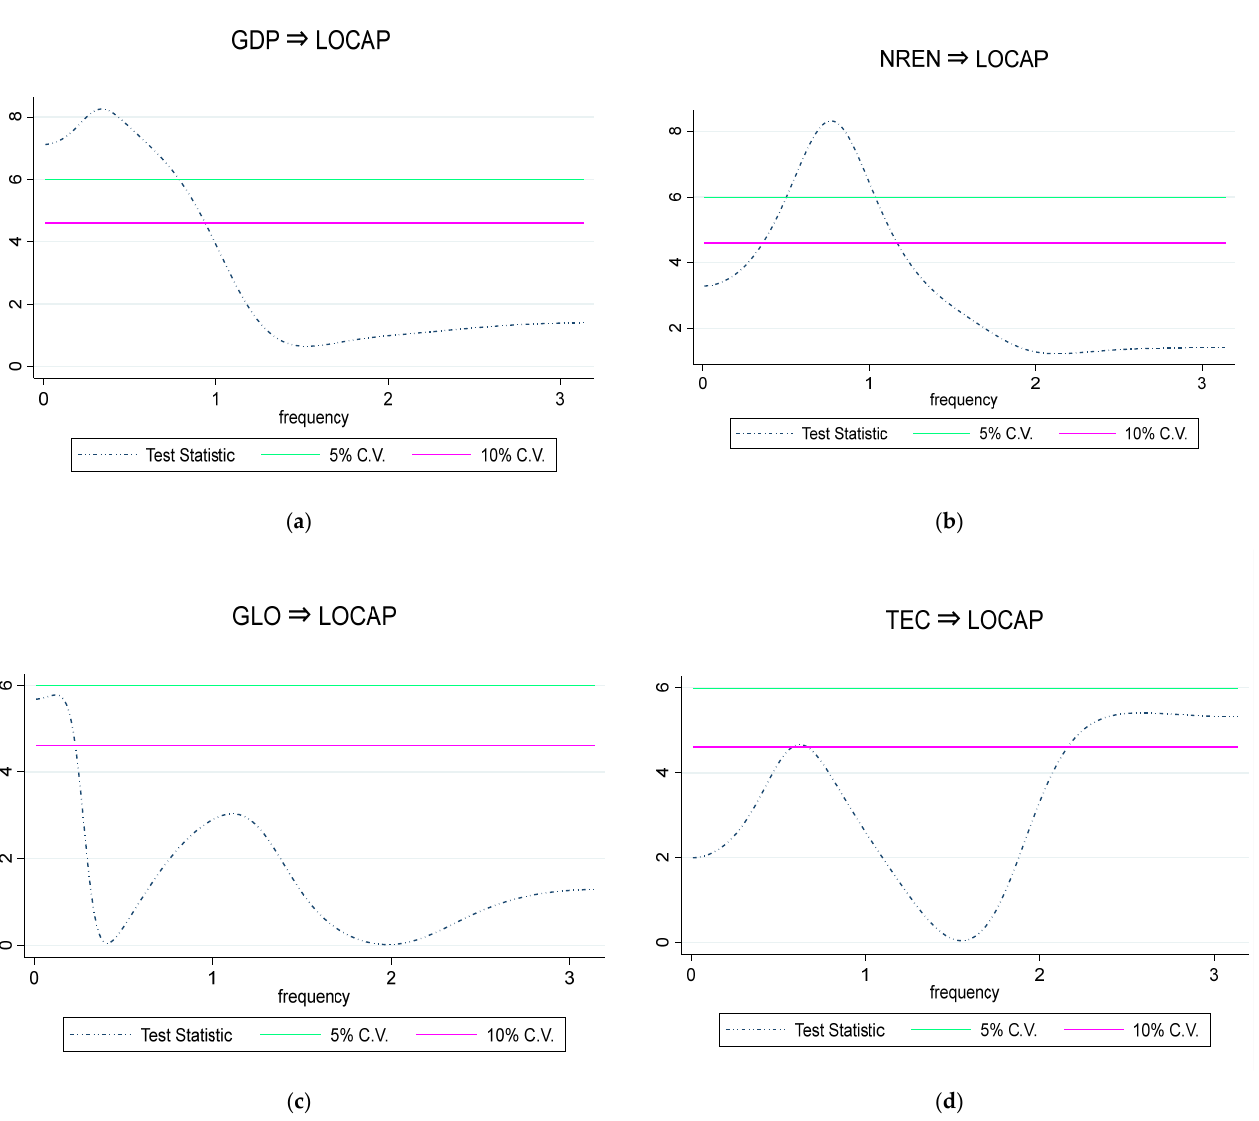
Figure 4. ( a ) Causal interaction of economic growth and load capacity factor. ( b ) Causal interaction of nonrenewable energy and load capacity factor. ( c ) Causal interaction of globalization and load capacity factor. ( d ) Causal interaction of technological innovation and load capacity factor.